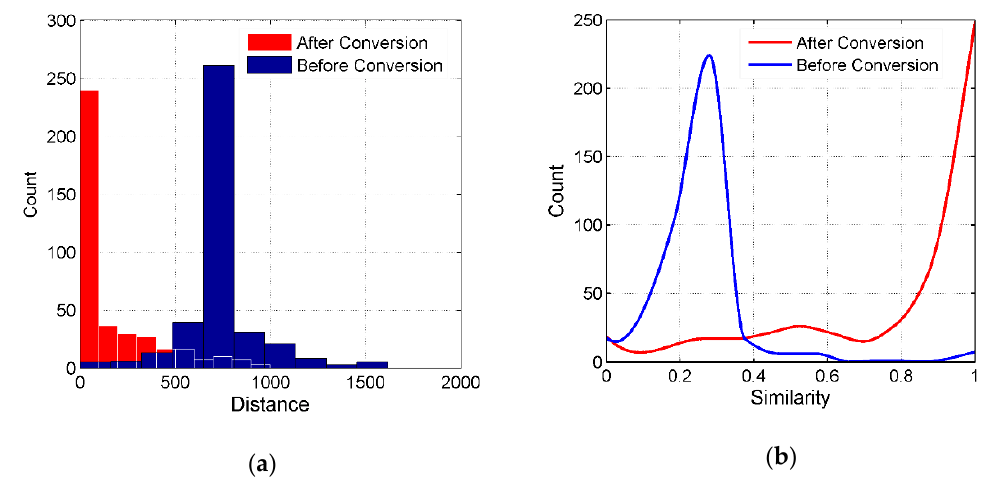
Figure 5. ( a ) The histogram of distance and ( b ) the curve of spatial similarity.